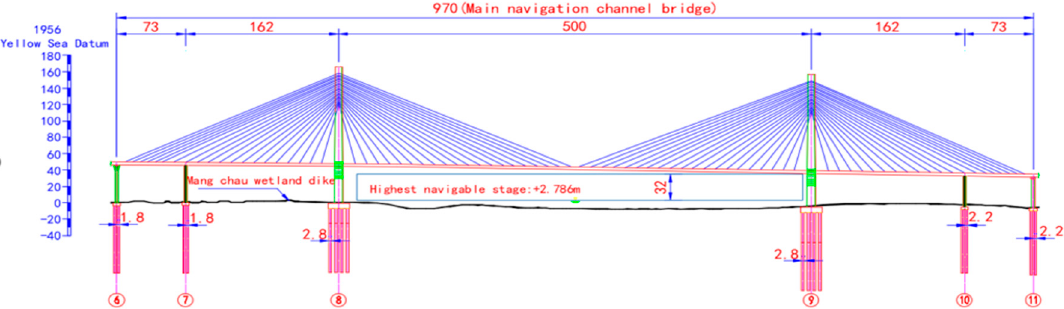
Figure 10. Span layout of the Honghe Bridge in Zhuhai.